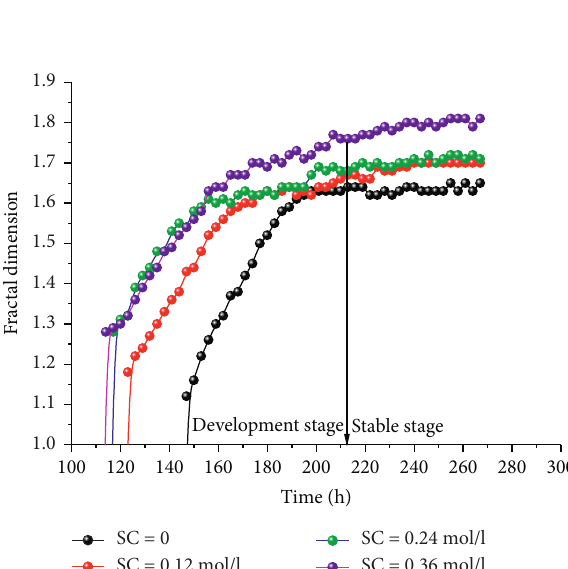
Figure 4: Fractal dimension varying with drying time under different drying